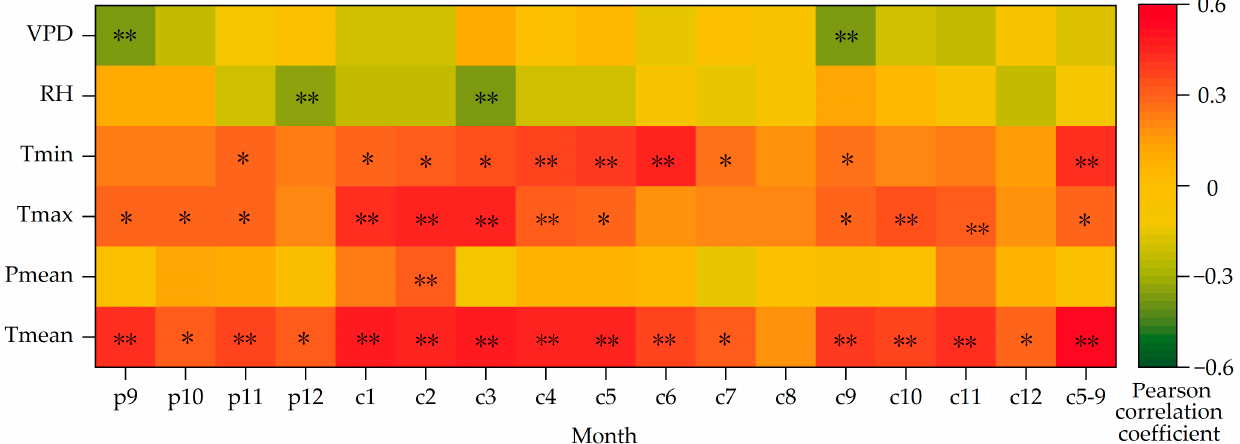
Figure 9. Correlations between WUE of Picea meyeri and monthly meteorological factors on Luya mountain (c represents the current year and p represents the previous year; * and ** symbol represent signi fi cant correlation at the 0.05 and 0.01 level, respectively).